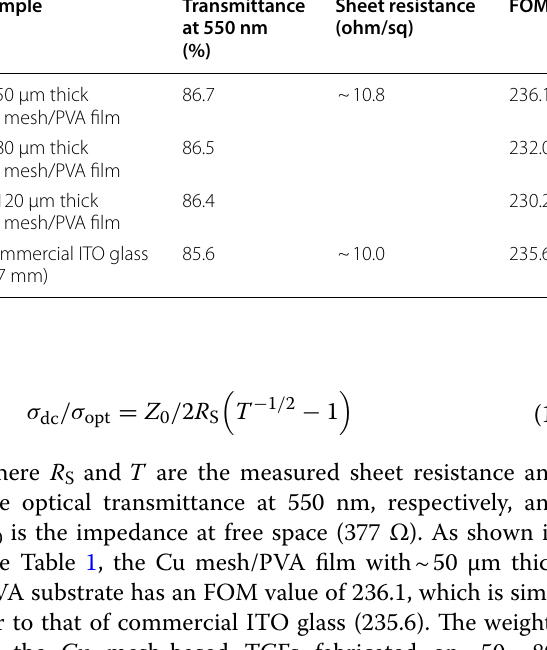
Table 1 Transmittance at 550 nm, average sheet resistance, and FOM of the commecial ITO glass and fabricated Cu mesh/PVA films with various substrate thicknesses